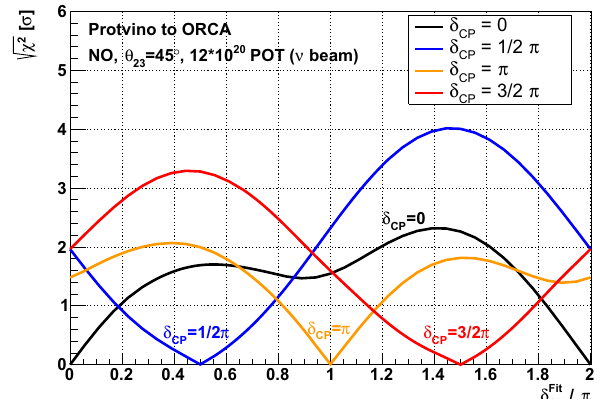
Fig. 10 Sensitivity to exclude certain values of the CP phase δ CP in the P2O experiment after 3 years of running with a 450 kW beam (positive beam polarity) for 4 example values of the true δ CP (0 ◦ , 90 ◦ , 180 ◦ (cid:2) Δχ 2 plot that would be and 270 ◦ ). Each curve represents an average obtained if the true δ CP value equals the example value indicated by the (cid:2) Δχ 2 = 1 corresponds to the 1 σ corresponding label.